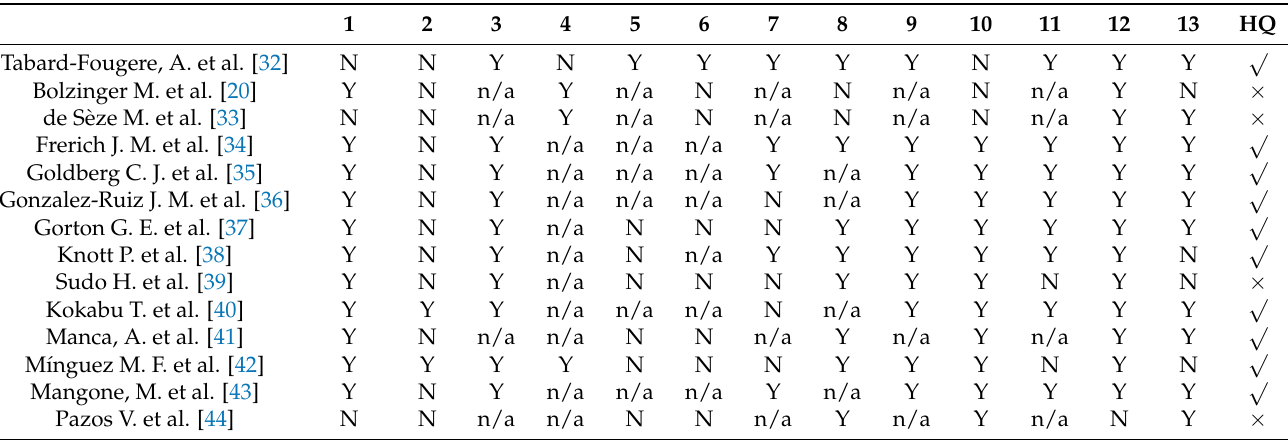
Figure 1. The flow chart of literature screening. Table 4. Results of study quality